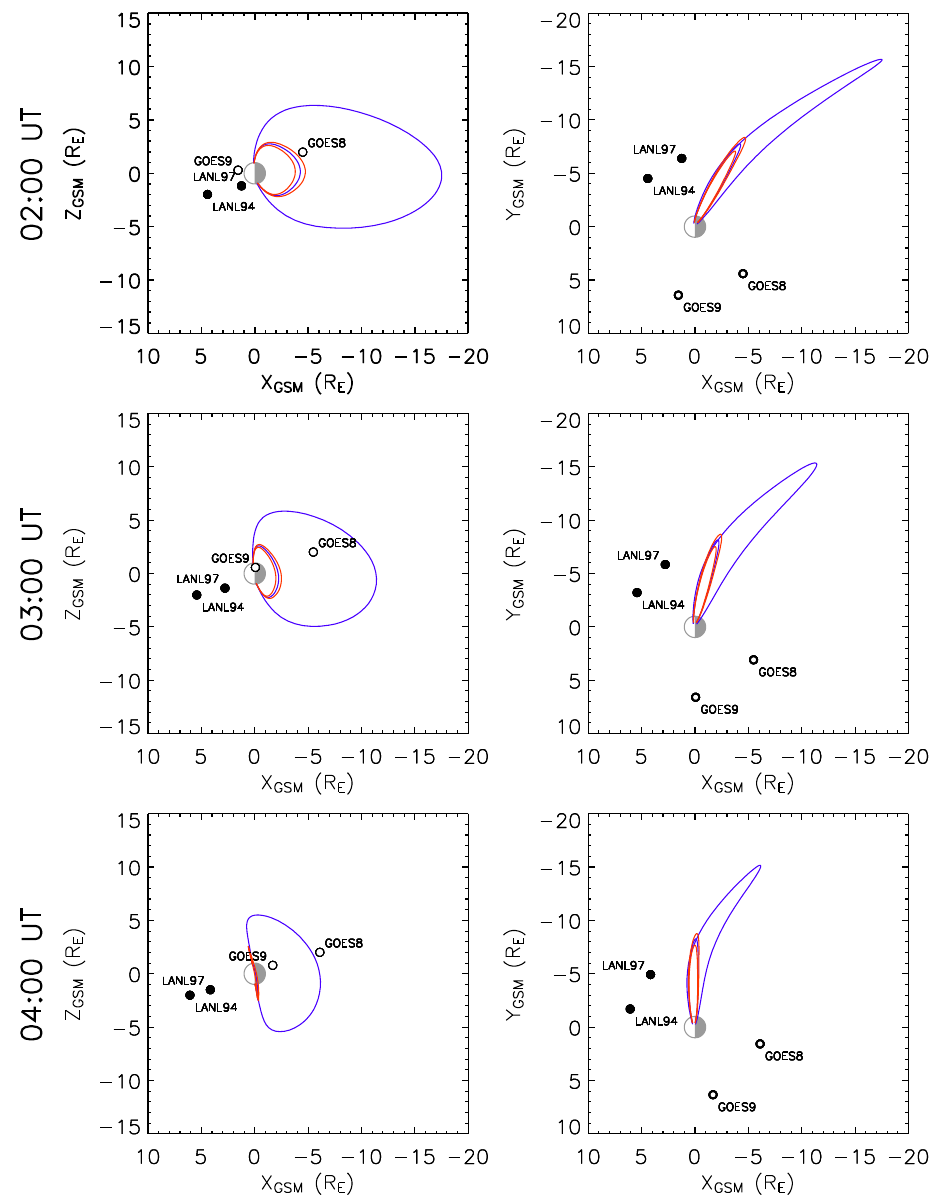
Fig. 5. Locations of the two LANL and GOES satellites in GSM coordinates at three times. The blue lines show the mapped field lines (from T96 model) that mark the latitudinal boundaries of the pulsation determined from HF radar and magnetometer observations. The red lines show the maximum extent of the region of enhanced precipitation (within the IRIS field of